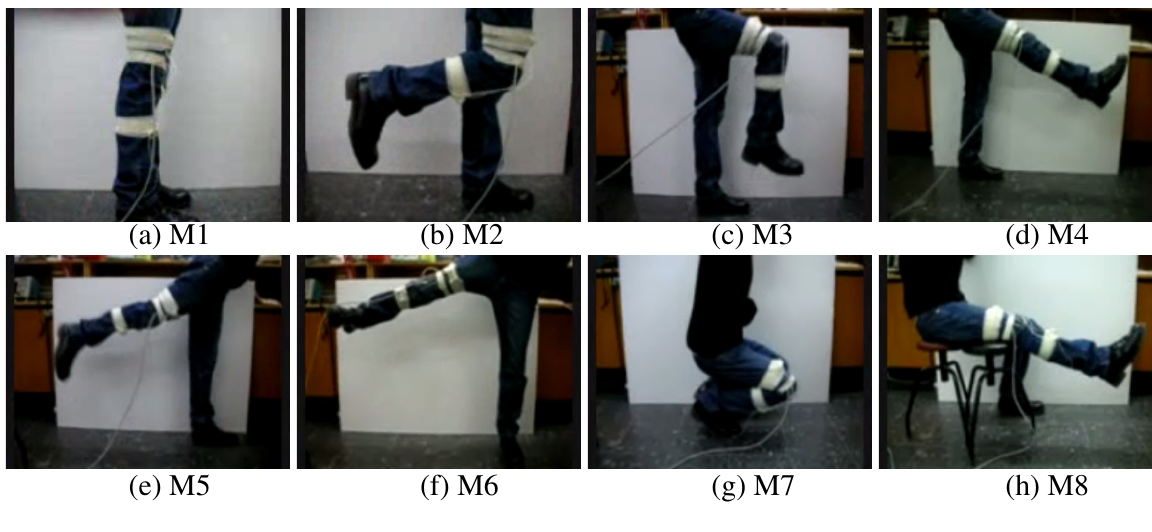
Figure 1. Eight different leg motions.